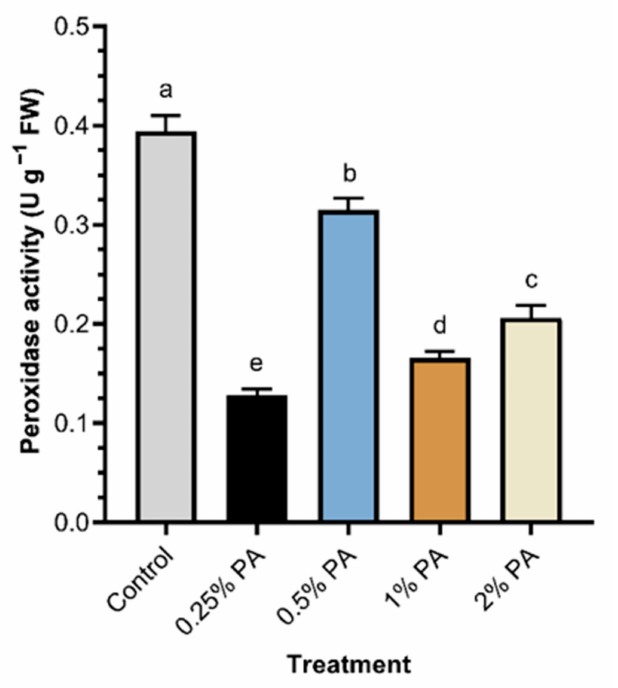
Figure 4. Peroxidase activity of tomato ‘Scotia’ fruit in response to pyroligneous acid treatment. Values are the means of four replicates and different lowercase alphabetical letters indicate significant ( p < 0.05) difference according to Fisher’s least significant difference (LSD) post hoc test. Error bars show the standard deviations. Table 4. Tomato ‘Scotia’ fruit elemental composition in response to pyroligneous acid (PA)